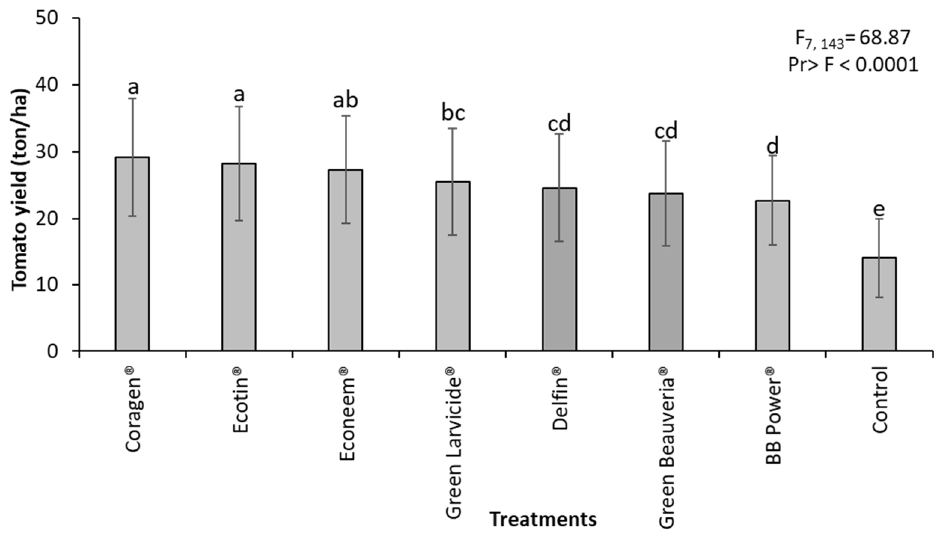
Figure 4. Mean (±SE) tomato yield in eight different treatments across three locations of Andhra Pradesh, India, two growing seasons (May–August 2018, September–December 2018) and three replications ( n = 18). Beauveria bassiana -based formulations are as follows: Green Beauveria ® and BB Power ® ; Bacillus thuringiensis -based formulations are as follows: Green Larvicide ® and Delfin ® ; neem-based formulations are as follows: Econeem ® and Ecotin ® ; chemical pesticide is as follows: Coragen ® . Mean(s) followed by same letter(s) are not significantly different based on Tukey’s HSD ( P = 0.05)